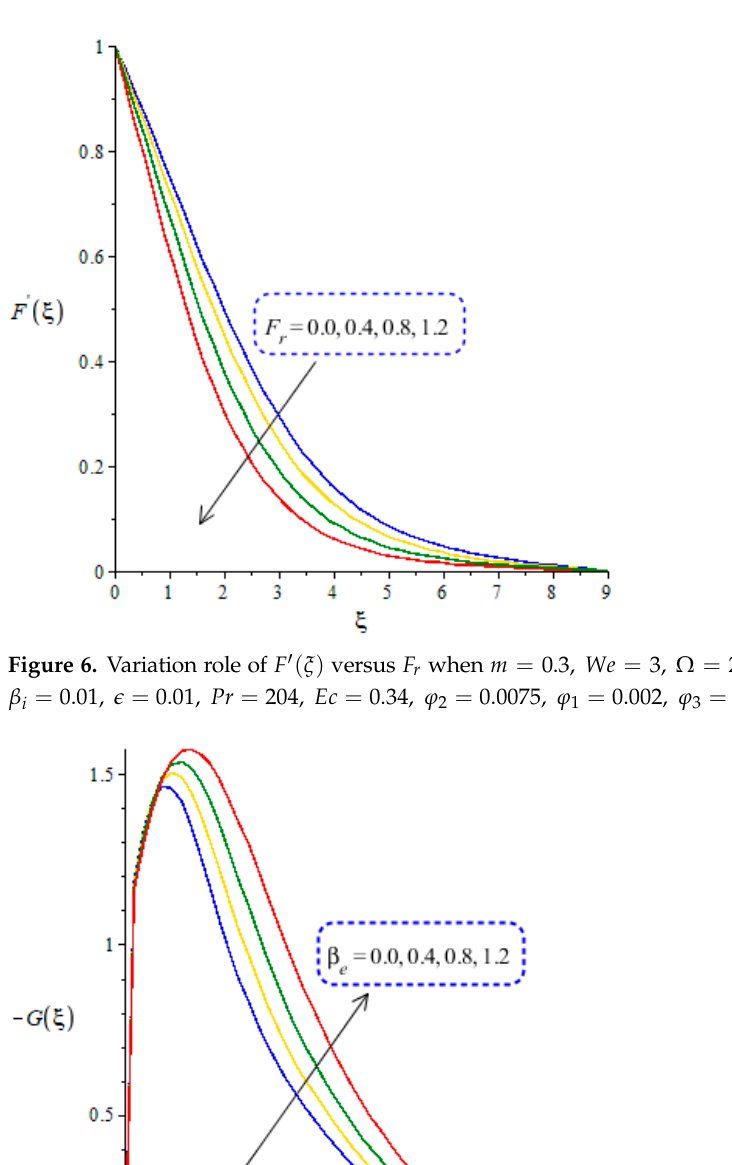
Figure 5. Variation role of −𝐺(𝜉) versus 𝐹 (cid:3045) when 𝑚 = 0.4, 𝑊𝑒 = 5, Ω = 2.0, 𝑀 (cid:2870) = 0.1,𝛽 (cid:3032) =